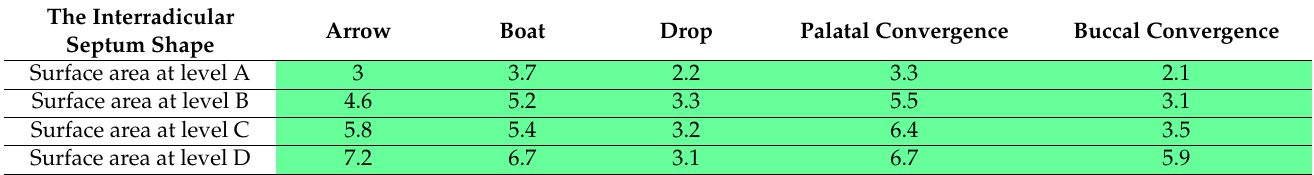
Table 6. The relationship between the average values of the IRS parameters obtained in the axial view and the implant surface area for the second maxillary molars according to the IRS shape (critical points are